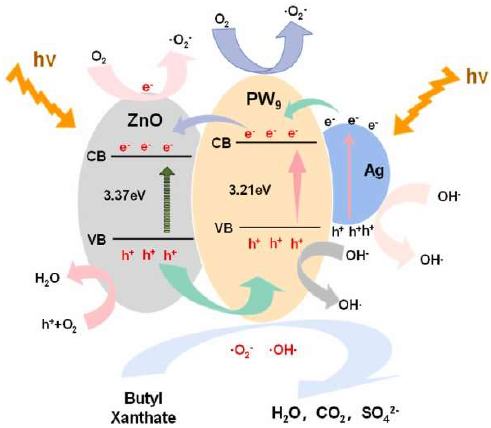
Figure 8. Diagram of the photocatalytic reaction mechanism (reproduced from Environ. Res. 2022, 214, 113776 with permission from